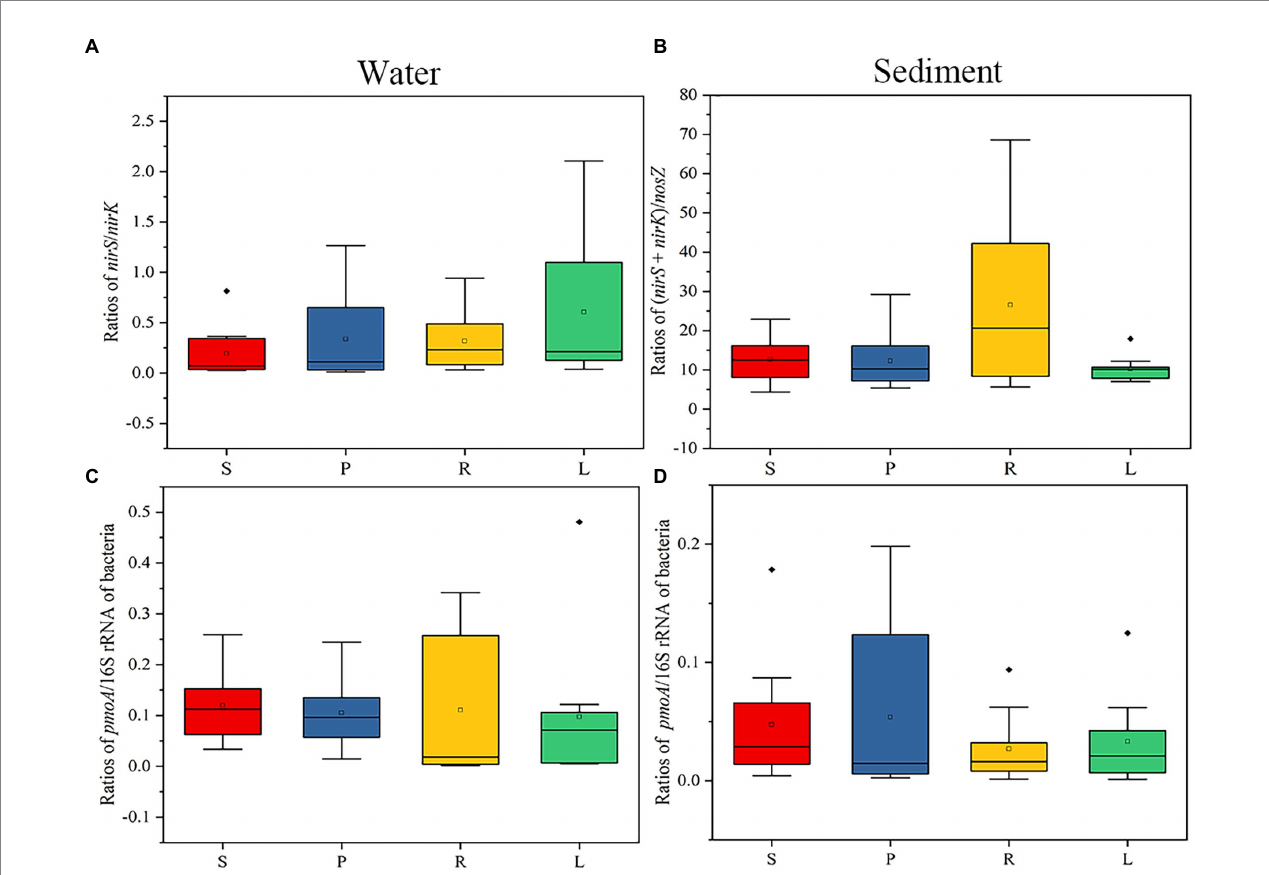
FIGURE 7 Gene ratios of functional enzymes in water and sediment of four habitats. (A) nirS/nirK copy number ratios in water. (B) ( nirS + nirK )/ nosZ copy number ratios in sediment. (C) pmoA /16S rRNA copy number ratios in water. (D) pmoA /16S rRNA copy number ratios in sediment. The bacteria represent the abundance of the total bacterial 16S rRNA